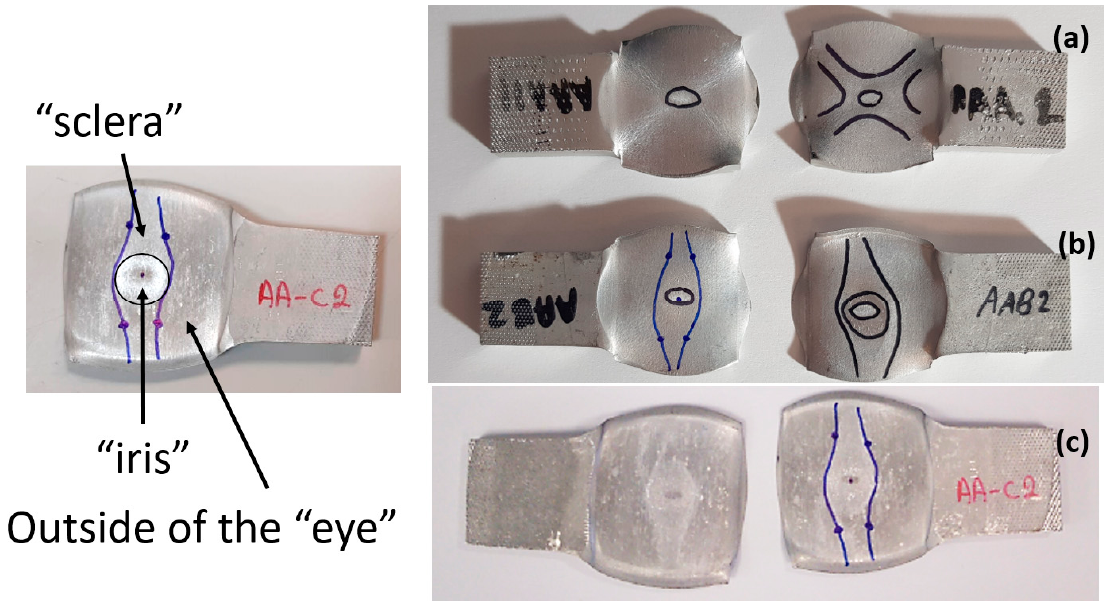
Figure 7. Examples of the interfaces revealed after debonding by a tension test. Specimen AAA1 (bonded at 300 °C, 46% reduction) ( a ) Specimens AAB2 (bonded at 400 °C, 49% reduction) ( b ), Specimen AAC2 (bonded at 500 °C, 53% reduction) ( c ).